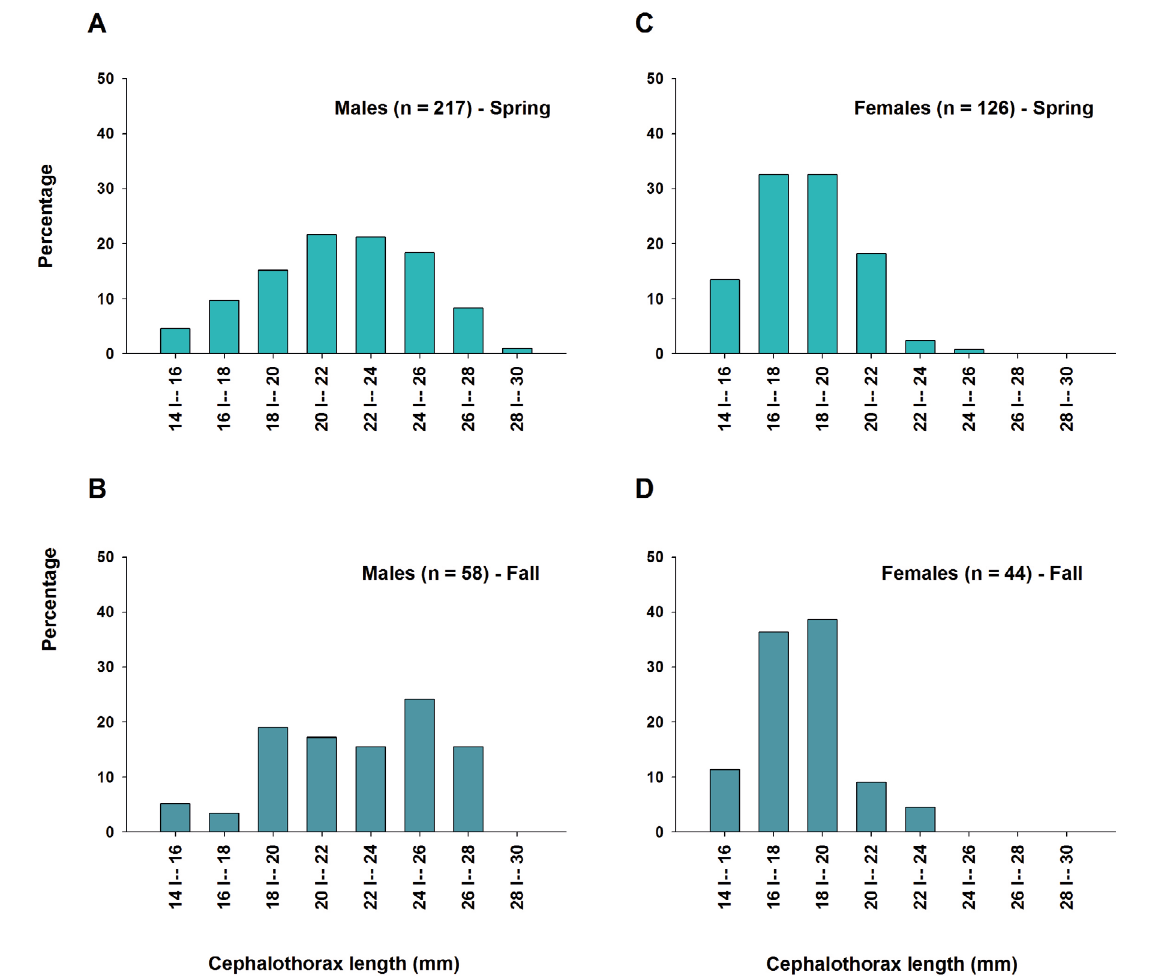
Figure 1. Size-class distribution (%) of Aegla longirostri Bond-Buckup and Buckup, 1994 sampled in spring 2010 and in fall 2011. Table 3. Estimation of the population size and density (ind.m-2) of Aegla longirostri Bond-Buckup and Buckup, 1994 using the estimators of Schnabel, Schumacher-Eschmeyer and the Bayesian model, in spring 2010 and in fall 2011. C. I.: Confidence interval for classic estimators or credibility interval for Bayesian Analysis Population size (C. I.) Density (ind/m 2 )